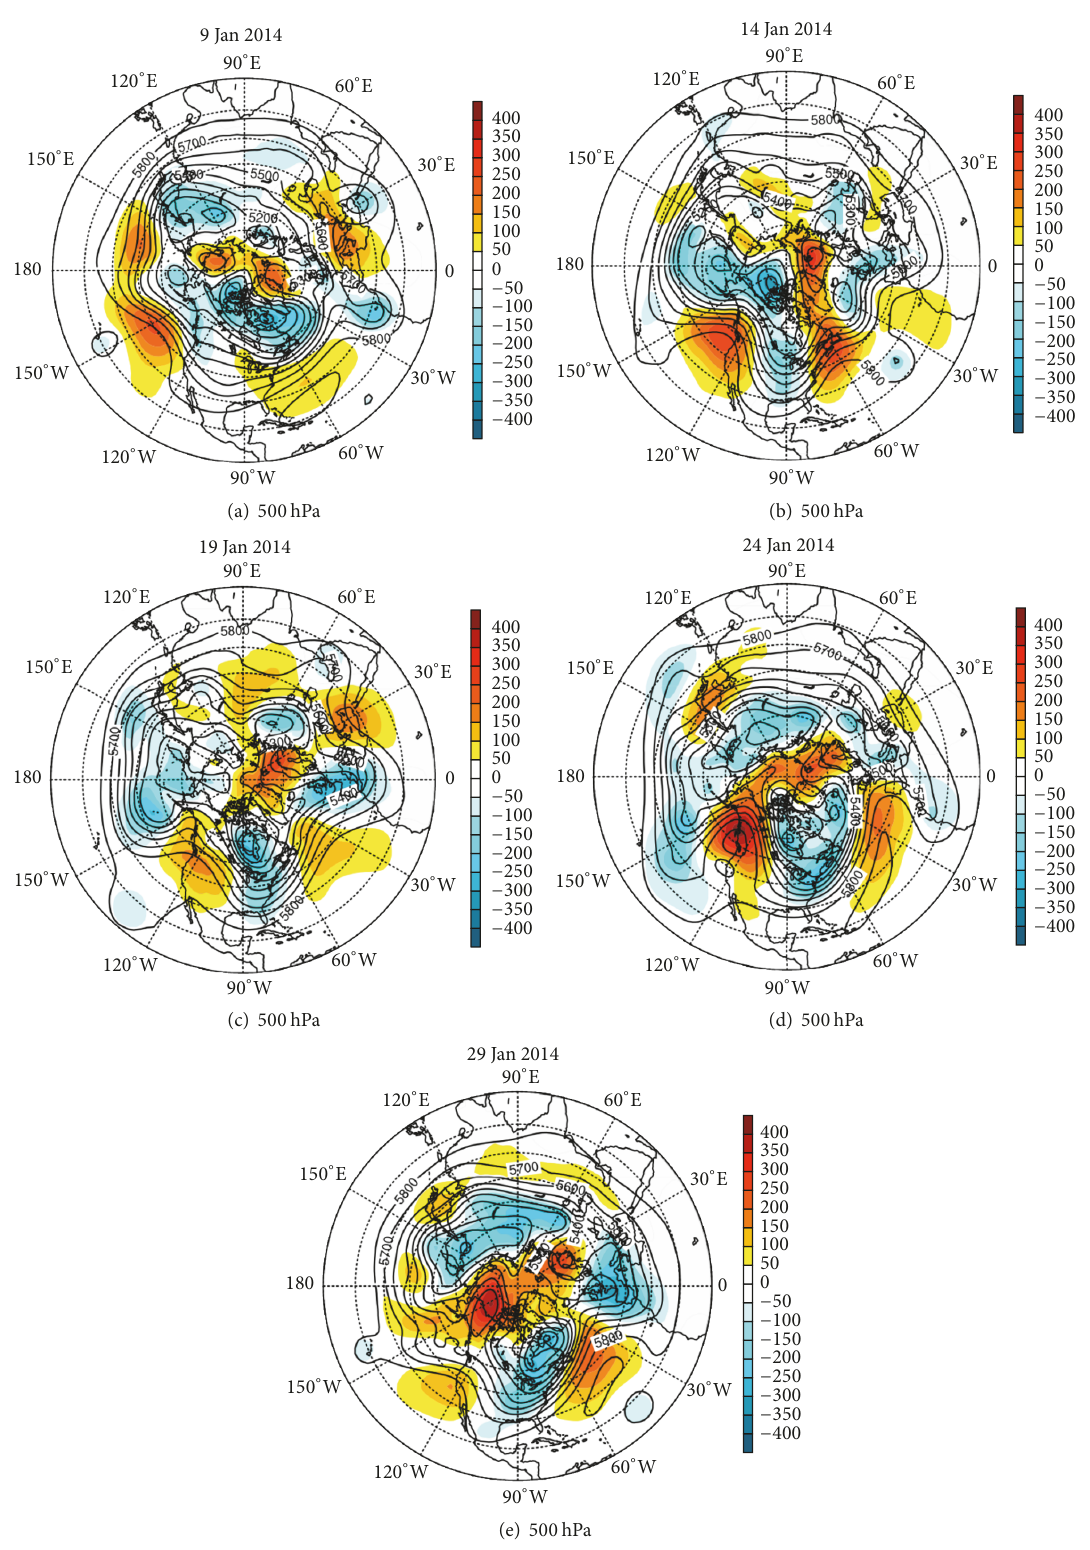
Figure 2: Daily geopotential height (contours; gpm) and its anomalies (shading; gpm) at 500 hPa in January 2014 relative to the 30-year climatology. The 30-year climatology refers to the 30-year average of January in 1981–2010. Contour interval: 100